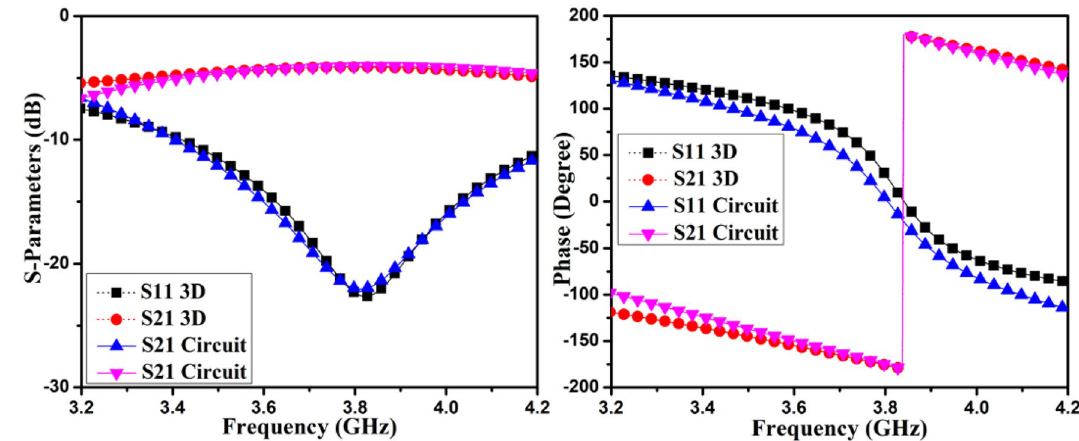
Figure 5. Phase plot and S-parameter simulated results of the 3D model and matching circuit of